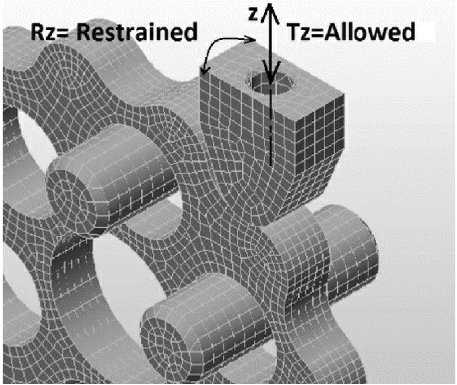
Figure 9. Illustration of the limitations of the pusher.